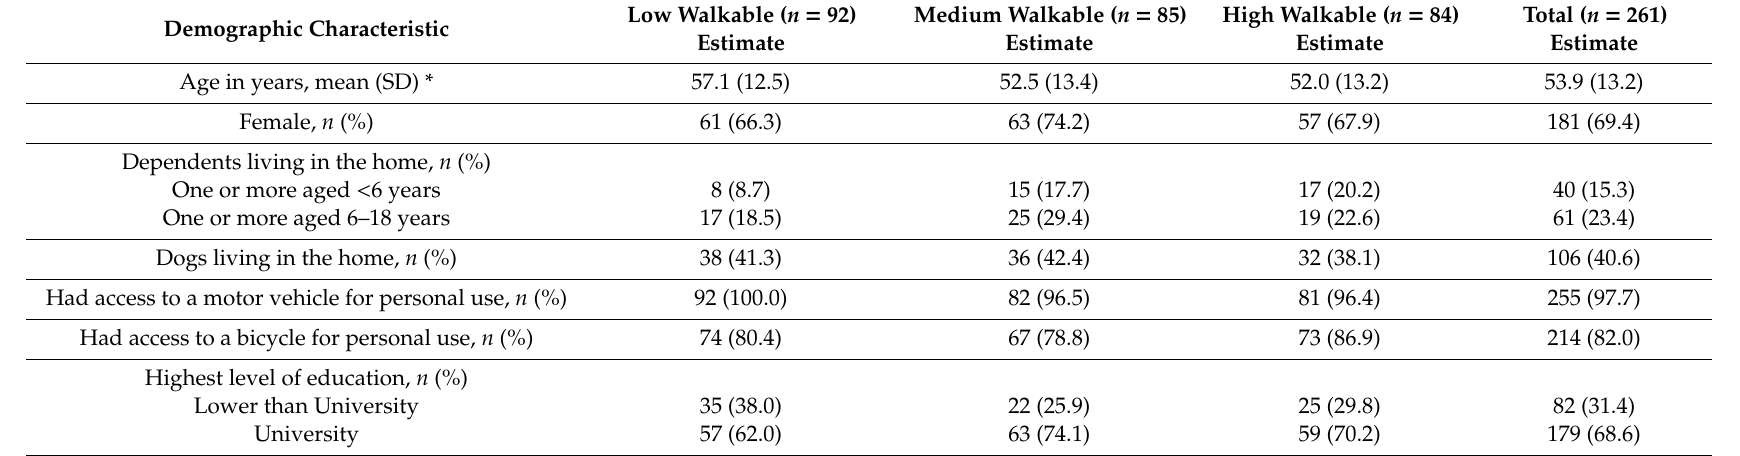
Table 1. Sample demographic characteristics by neighbourhood walkability.